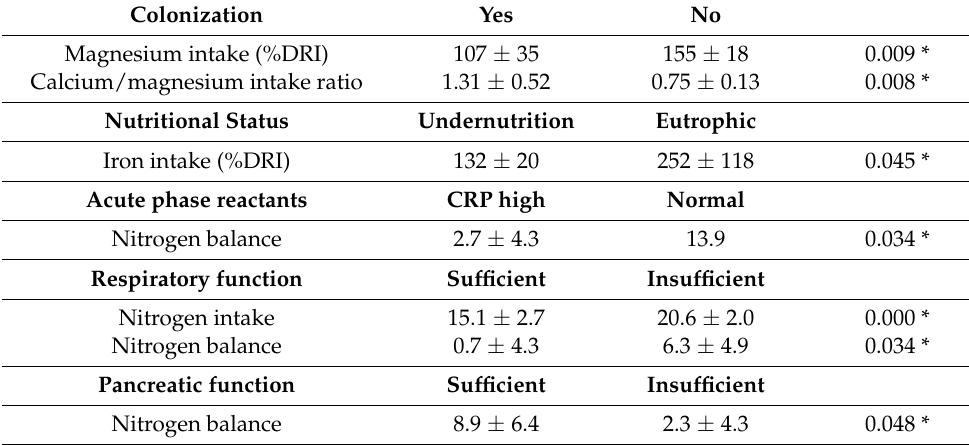
Table 3. Significant differences between cystic fibrosis patients ( n = 17